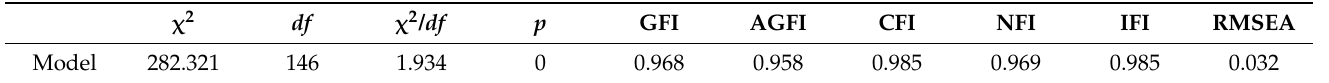
Table 5. Model fit.